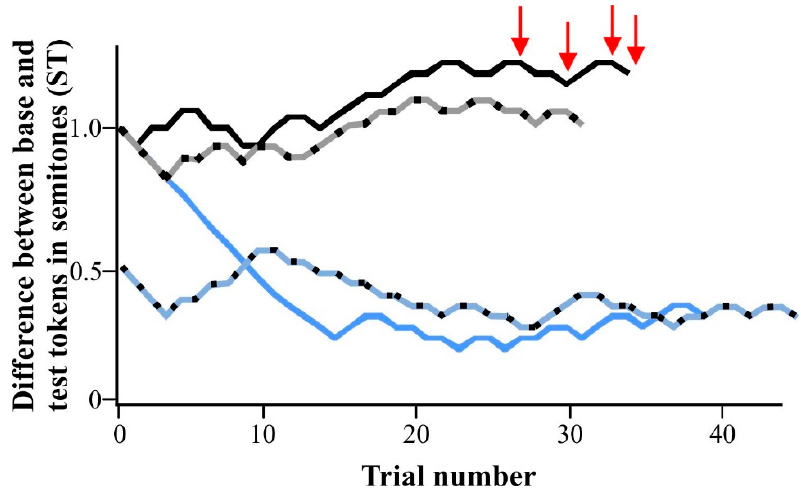
Figure 1. Experimental runs from two participants. The first participant started both run #1 (solid black line) and run #2 at 1 semitone (ST, dotted black line). The second participant started run #1 at 1 ST (solid blue line) and started run #2 at 0.5 ST (dotted blue line). Red arrows indicate the last four reversals that were calculated for the just-noticeable-difference (JND) for participant #1, run #1. Step-size magnitude was defined as the magnitude of change in f o during the adaptive